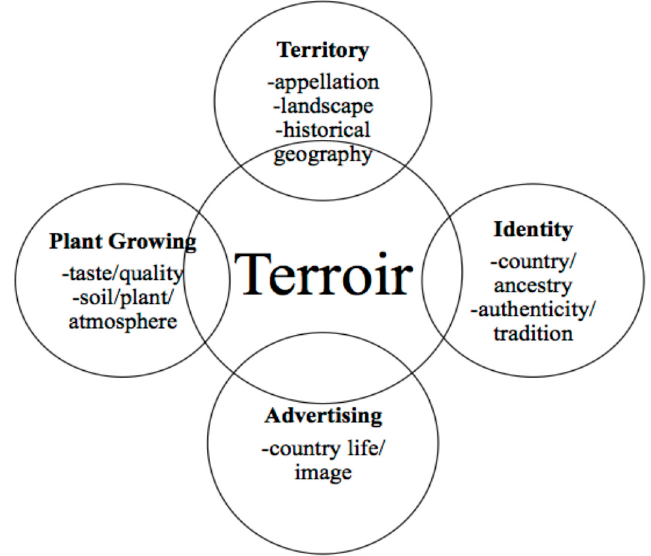
Figure 2. A typology of viticultural terroir (adapted from [32], with permission from Vaudour,